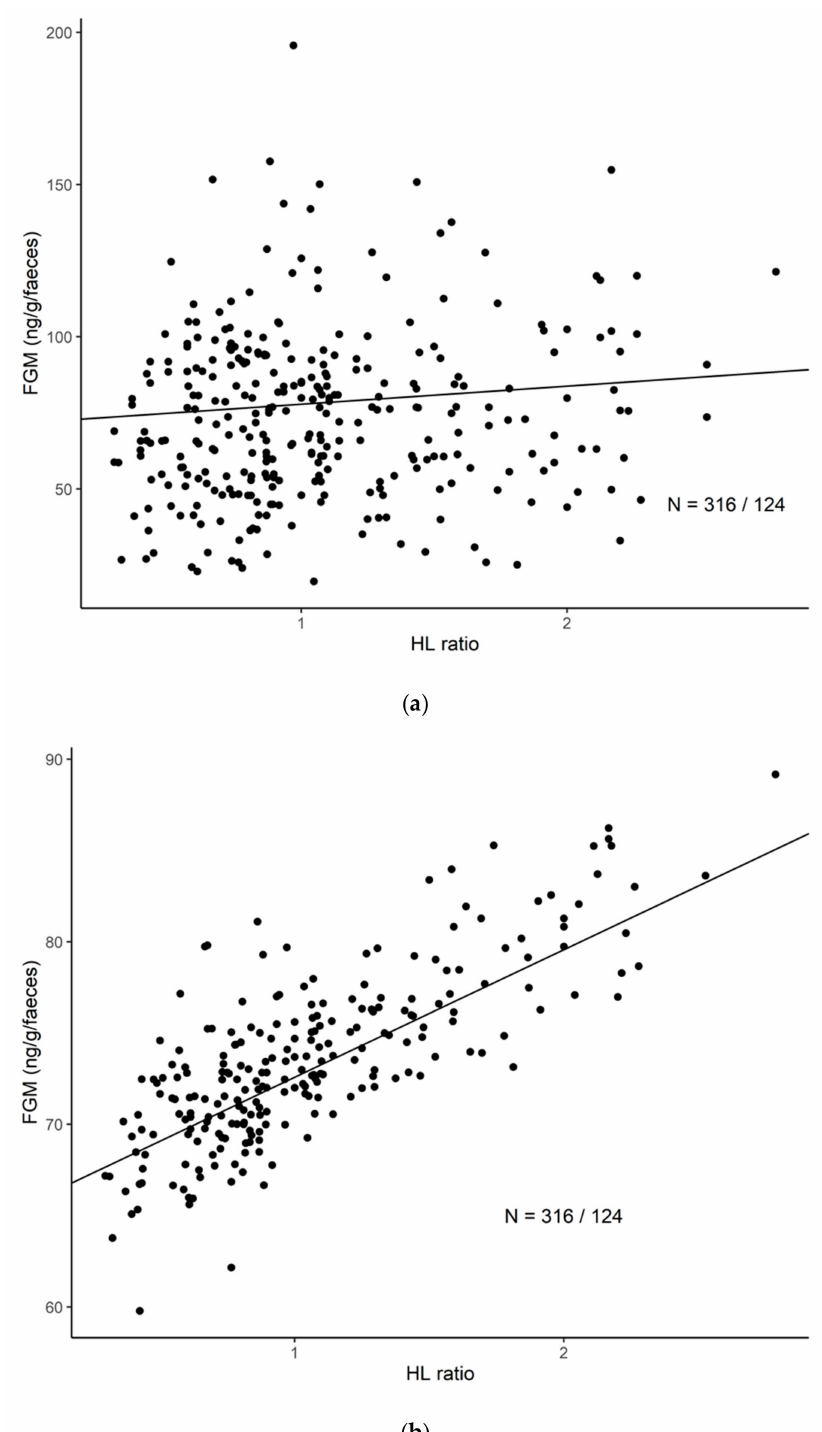
Figure 1. ( a ) The relationship between the H / L ratio and FGM concentrations in Asian elephants. The predicted curve is plotted against the observed raw data. The sample size shown refers to the number of samples / total number of individuals included in the study. ( b ) The relationship between the H / L ratio and FGM concentrations in Asian elephants. Here, the predicted curve is plotted against the predicted data after adjusting for the confounding variables shown for Model 1 in Table 2. The sample size shown refers to the number of samples / total number of individuals included in the